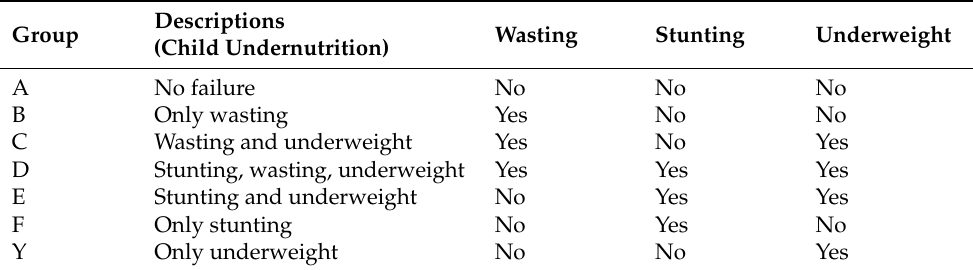
Table 1. Classification of a composite index of anthropometric failure to assess undernutrition among the children under 2 years